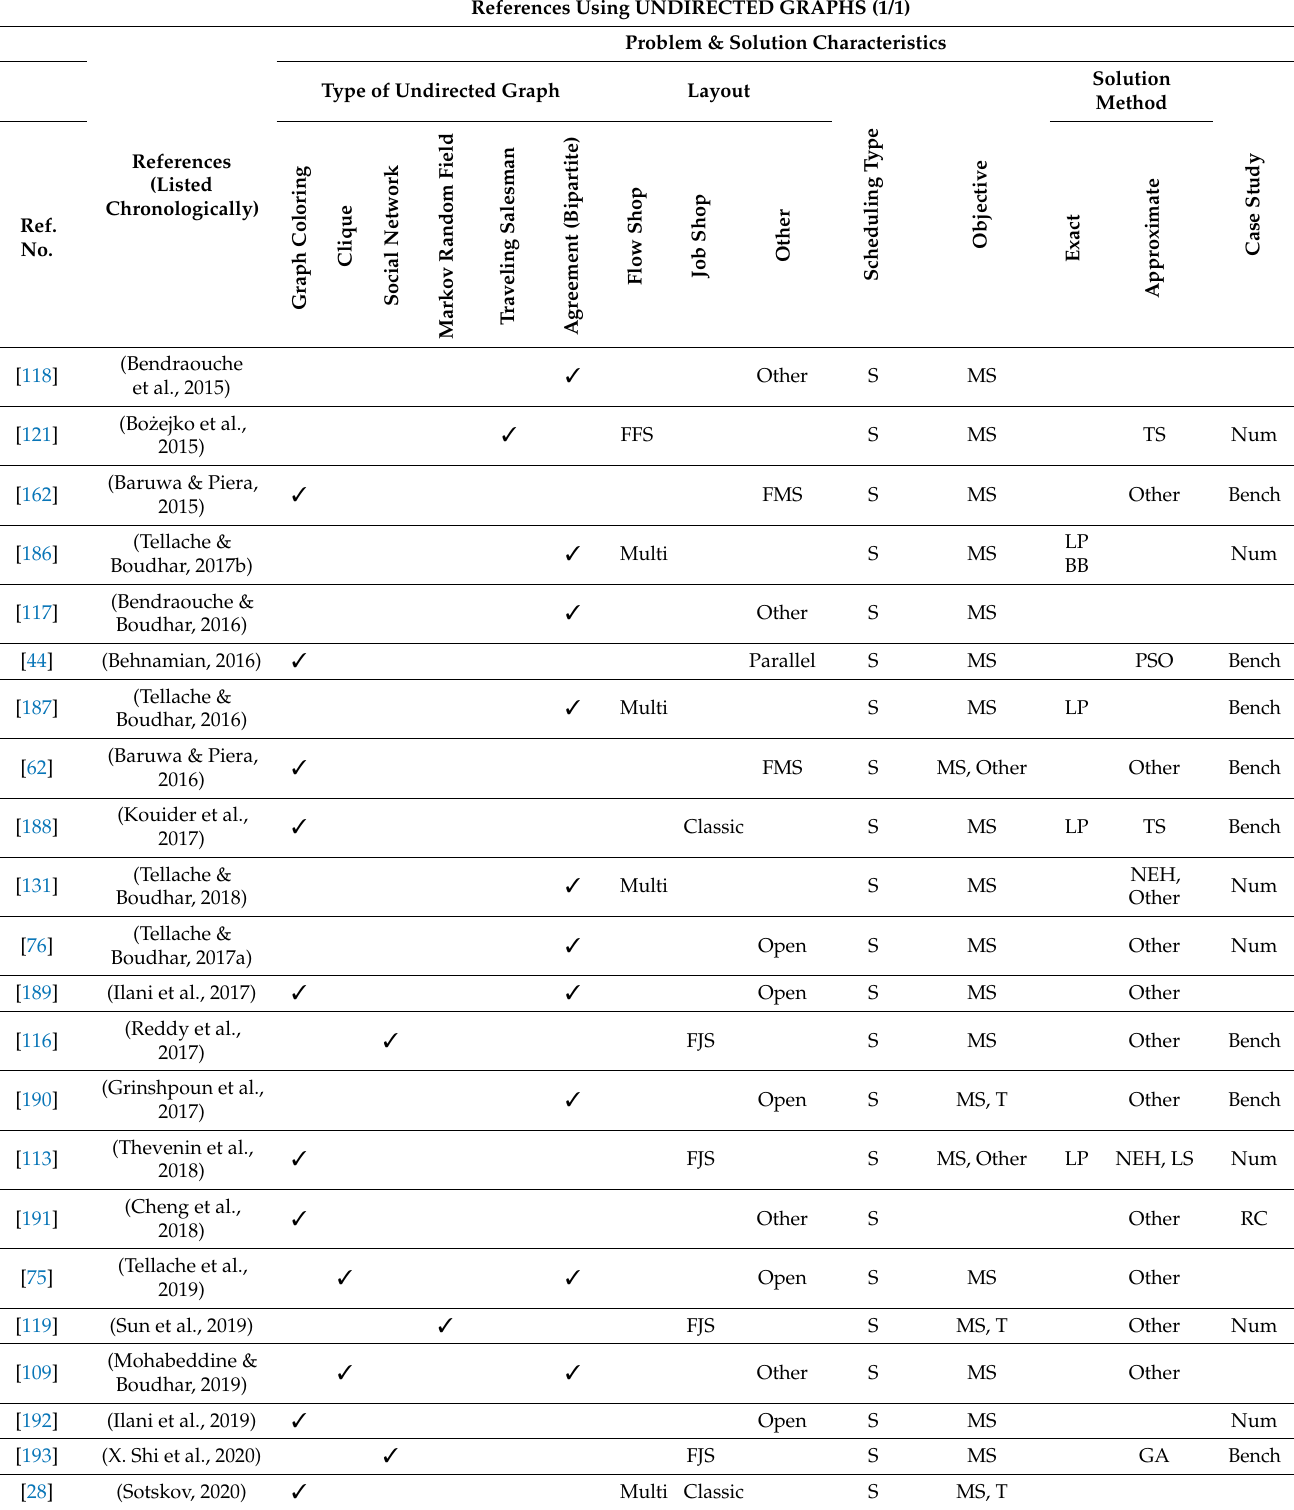
Table 7. Overview of references in the dataset using undirected